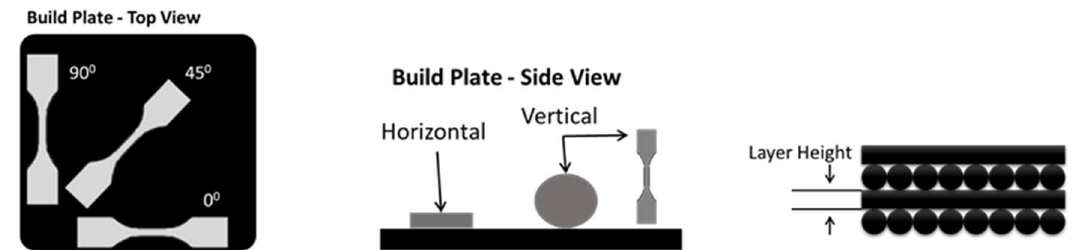
Figure 2. Visualization of sample orientation and layer height.